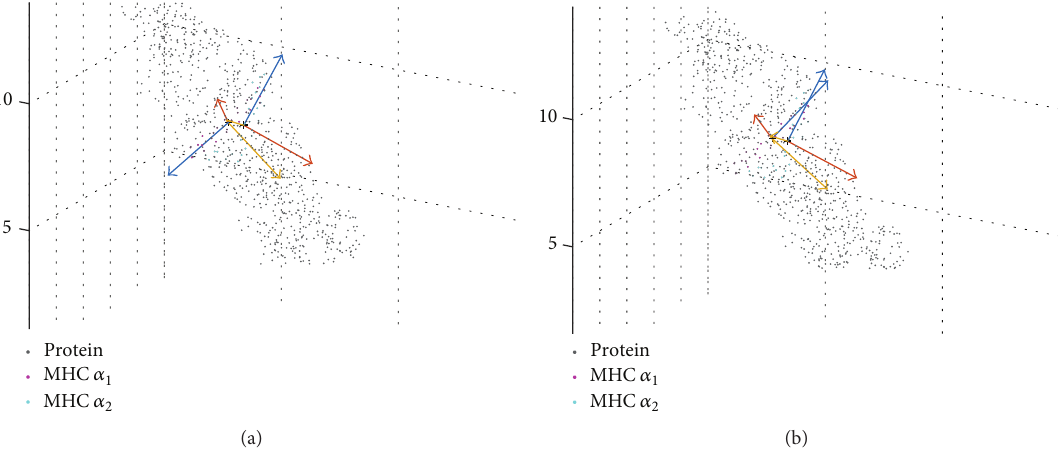
Figure 8: Eigenvectors switching orientations between frames. (a) Eigenvectors of first frames. (b) Eigenvectors of central frames 𝑘 𝑉 and 𝑘 𝑊 . If calculated from the atomic coordinates, the first eigenvectors ( v 1 , w 1 : blue) result with almost opposite orientations in the first frame but very similar orientations in the central frames of each domain. Note that eigenvectors refer to different frames 𝑘 𝑉 and 𝑘 𝑊 , respectively, but atoms of the molecule are plotted only once. Coloring: v 1 , w 1 : blue; v 2 , w 2 : red, and v 3 , w 3 : yellow.